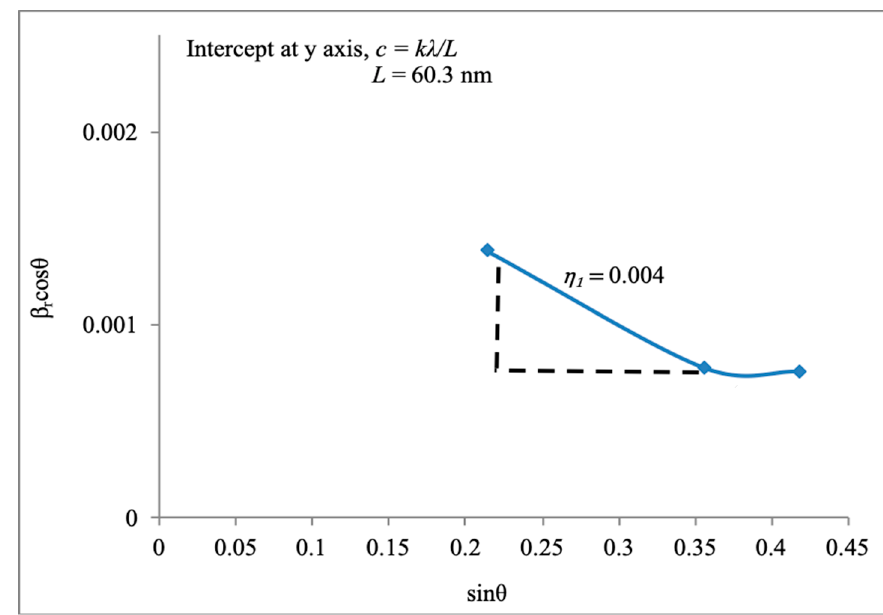
Processes 2018 , 6 , x FOR PEER REVIEW Figure 8. Plot of β r cos θ versus sin θ from XRD data of the 5 min sample. Figure 8. Plot of β r cos θ versus sin θ from XRD data of the 5 min sample.